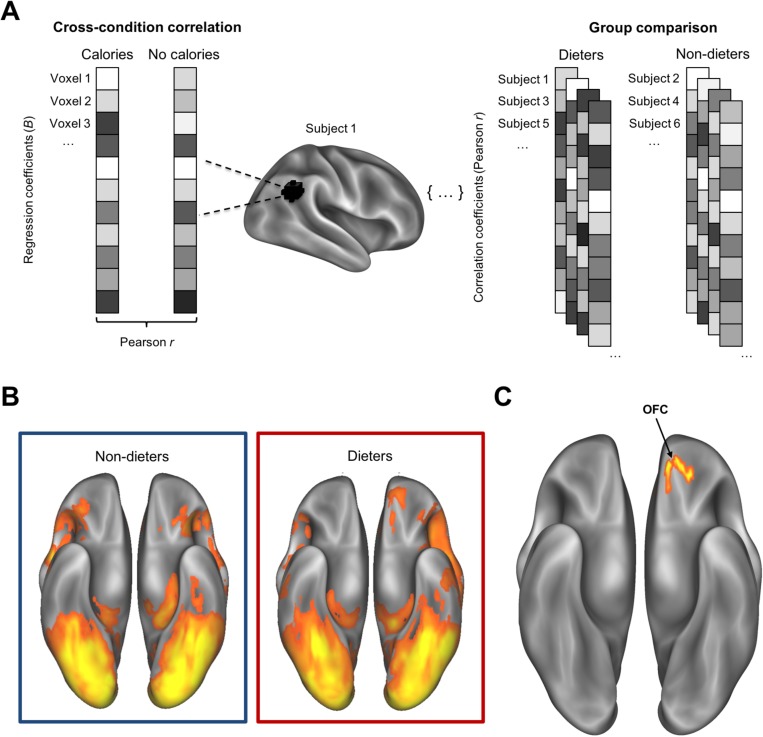
(A) Schematic of multivariate searchlight RSA comparing activation to foods images presented with and without calories. All voxels within a 9-mm searchlight sphere contribute to the cross-condition correlation value at that location. This process is iterated across the entire brain to generate a whole-brain cross-condition correlation map for each subject. Between subjects, a whole-brain group comparison reveals any group differences in cross-condition correlation values. (B) Statistical maps of whole-brain cross-condition correlations for non-dieters and dieters (voxelwise t > 10, cluster correction p < 0.001). (C) Statistical map representing the interaction between group (DIETERS > NON-DIETERS) and condition (NO CALORIES/CALORIES) pattern similarity from multivariate searchlight RSA (voxelwise p < 0.01, thresholded to 60 contiguous voxels), featuring one cluster in the left OFC (-18, 42, -15, ventral view).